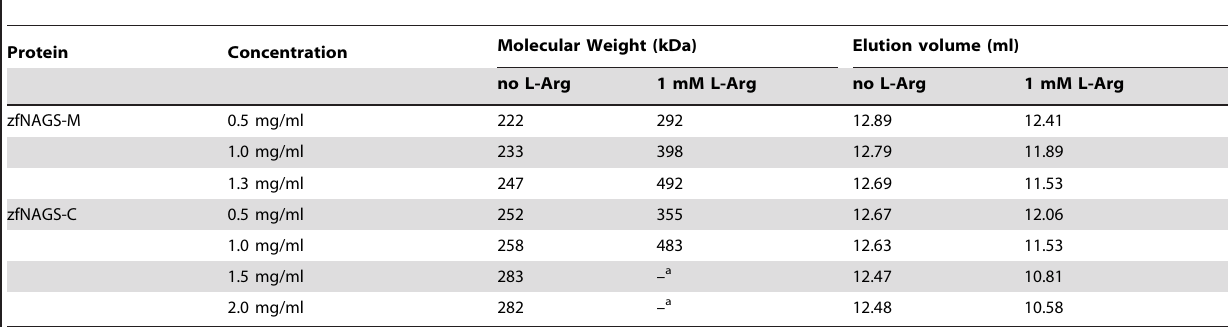
Table 2. Molecular weights and elution volumes of zfNAGS-M and zfNAGS-C in the presence and absence of L-arginine.